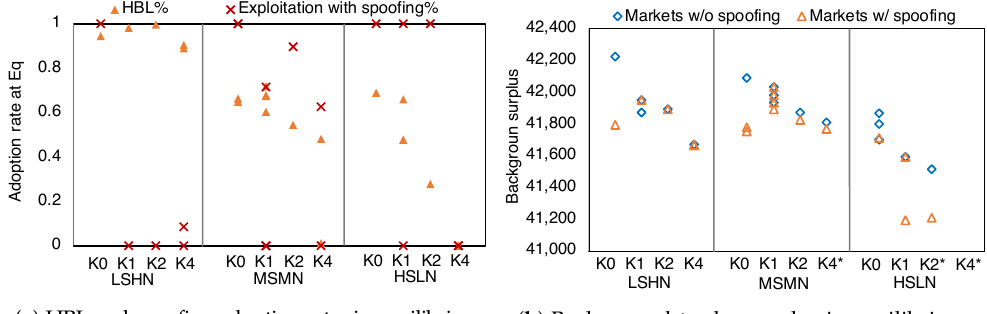
Figure 11. Equilibrium outcomes in games with and without cloaking. Each marker represents one equilibrium of the